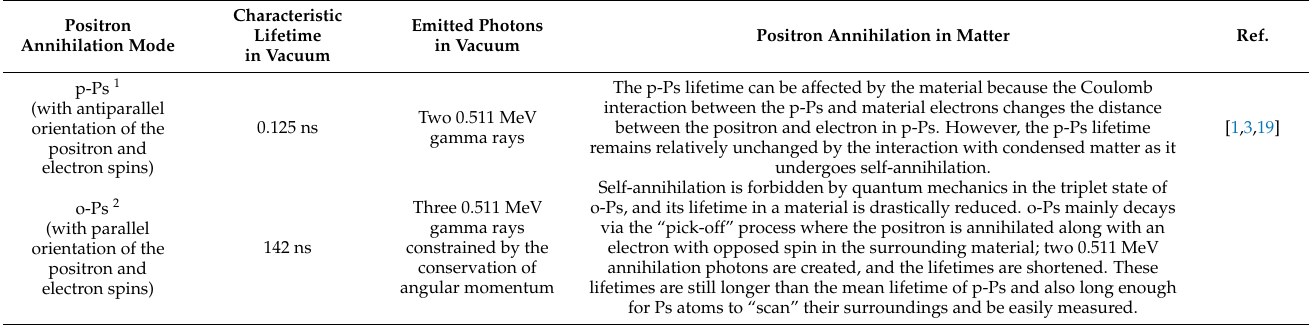
Table 1. Positron annihilation